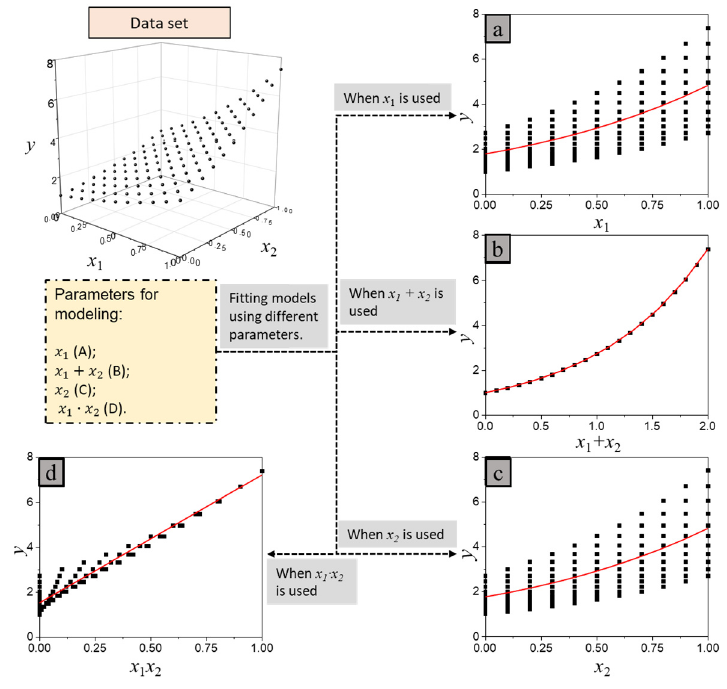
Figure 1. Parameters’ effects on the dispersion of Y. ( a ) x 1 was used to develop a model; ( b ) x 1 + x 2 was used to develop a model; ( c ) x 2 was used to develop a model; ( d ) x 1 x 2 was used to develop a model.